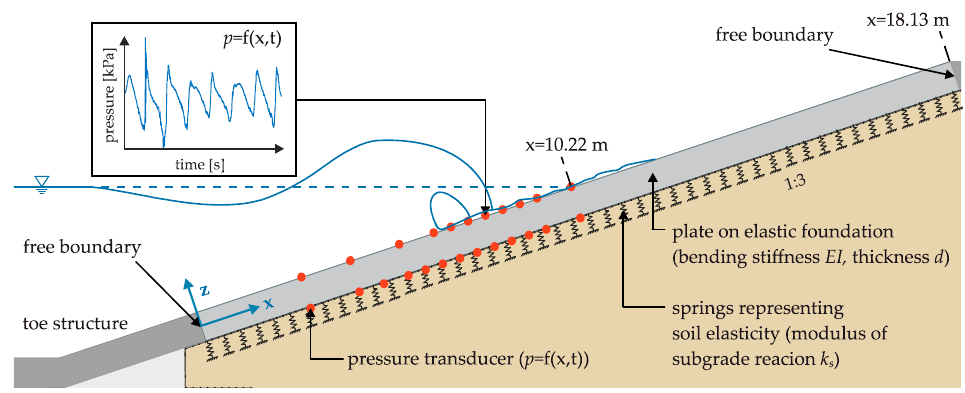
Figure 7. Model of the MGRRs as a plate on an elastic foundation with boundary conditions and model parameters (after [28]).